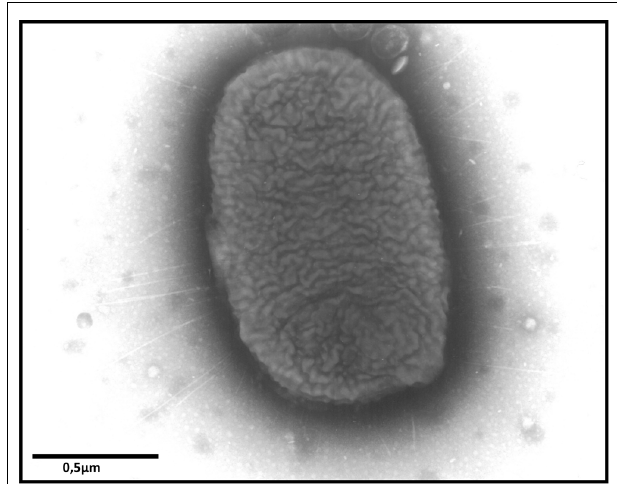
FIGURE 1 |Transmission electron microscopy image showing fimbriae of S. Enteritidis after culture on Sven Gard plates. Bar represents 0.5 μ